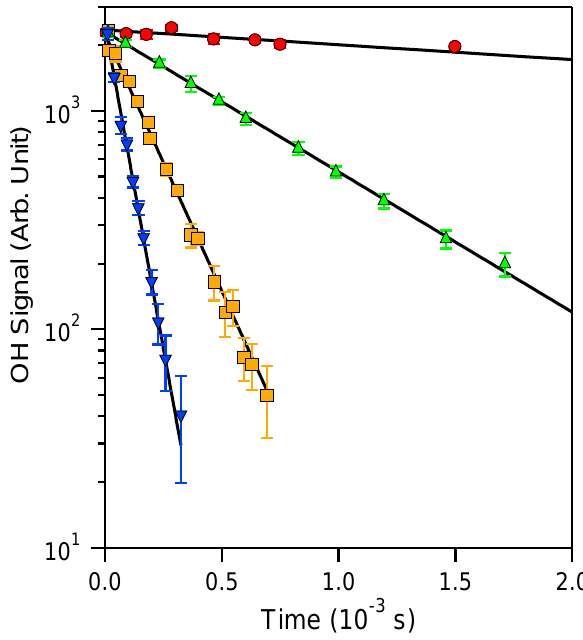
Fig. 2. Representative OH radical pseudo-first-order decays mea- Figure 2 sured for the reaction of OH with 1-penten-3-ol, k 2 . Exper- imental conditions: 50Torr (He) at 297K, [OH] 0 =1.4 × 10 11 moleculecm − 3 , photolysis laser fluence=11mJcm − 2 pulse − 1 for 1-penten-3-ol concentrations of (in units of 10 14 moleculecm − 3 ) : 0 ( (cid:13) ), 0.16 ( 1) , 0.79 ( (cid:3) ), and 1.9 ( ∇ ). The error bars are the 2 σ precision error in the measured OH signal. The lines are the least- squares fits of the data to Eq. (2) where the slope yields k 0